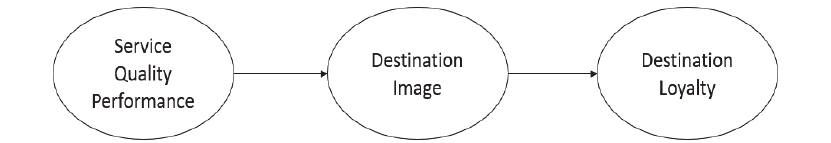
Fig. 1 . Relationship between Variables (Adopted from Akroush, Jaraisat, Kurdieh, Al-faouri, Qatu, 2016: p.22) H 1 : Service quality performance has a positive influence on destination